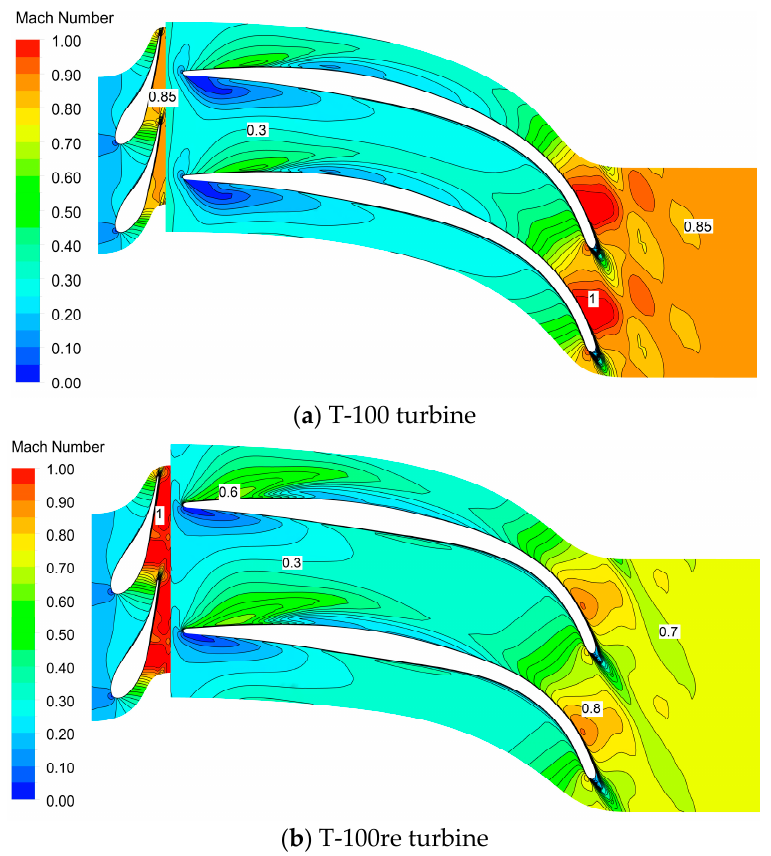
Figure 12. Comparison of Mach number contour at the mid-span section.